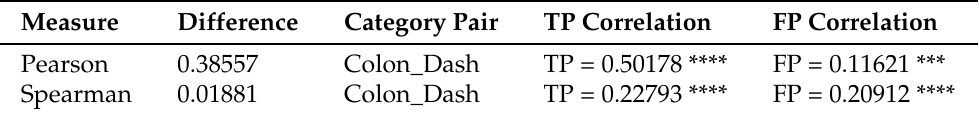
Table 17. Colon and Dash in High.